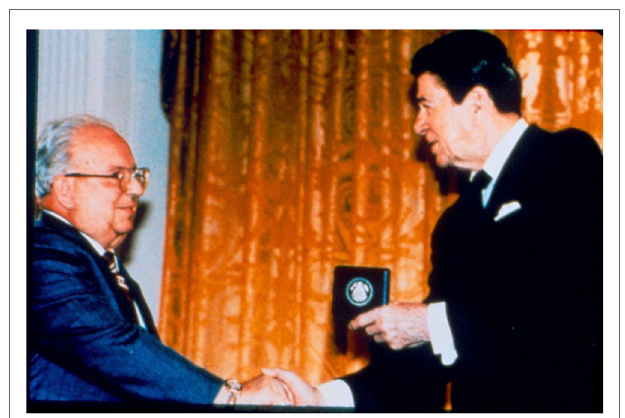
FiGURe 15 | Dr. S. Donald Stookey receiving National Medal of Technology from President Ronald Reagan (1986)